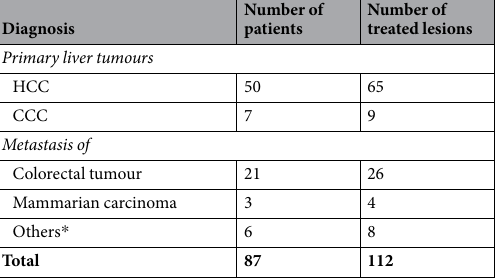
Table 2. Tumour types of 87 patients treated with irreversible electroporation of malignant liver tumours. * Carcinoma of unknown origin, neuroendrocrinic tumour.